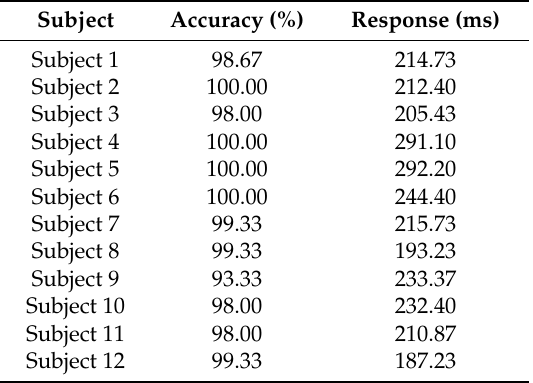
Table 1. Recognition rate and response time of all subjects.